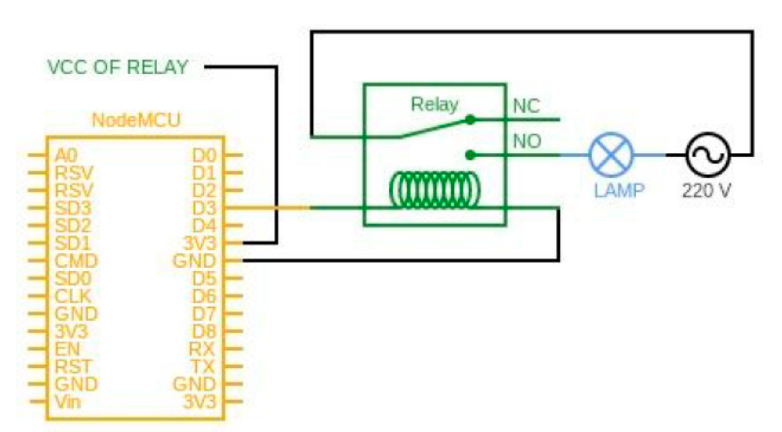
Figure 2. Circuit diagram of lamp.